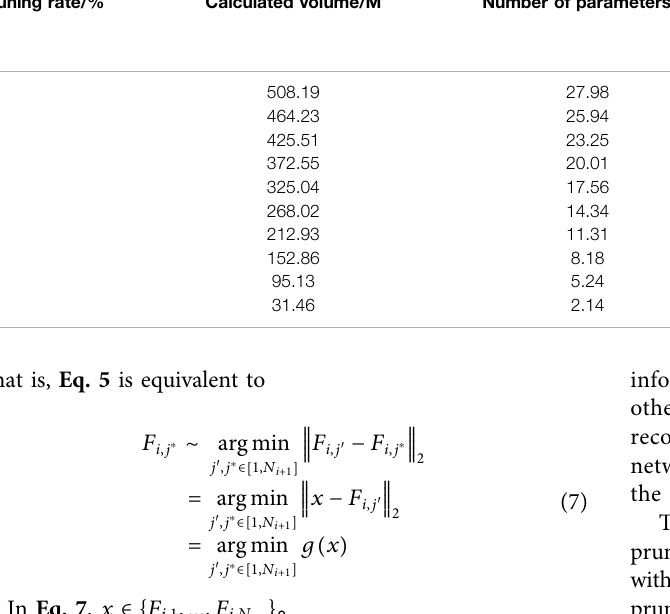
TABLE 5 | Effect of different pruning rates on the FPN-ResNeSt50 model. Pruning rate/% Calculated volume/M Number of parameters/M Calculated volume decline